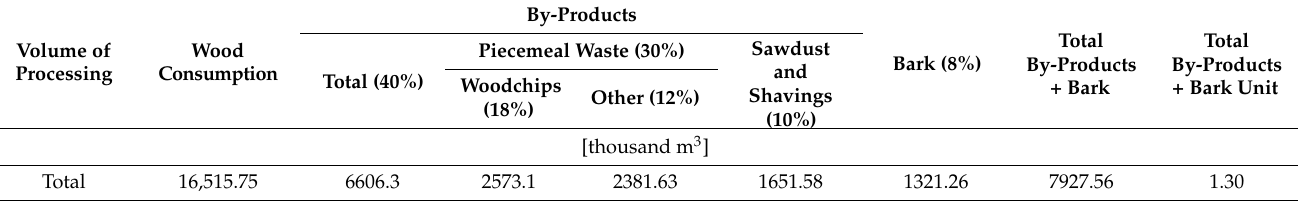
Table 1. Quantity of by-products from wood processing in sawmills in